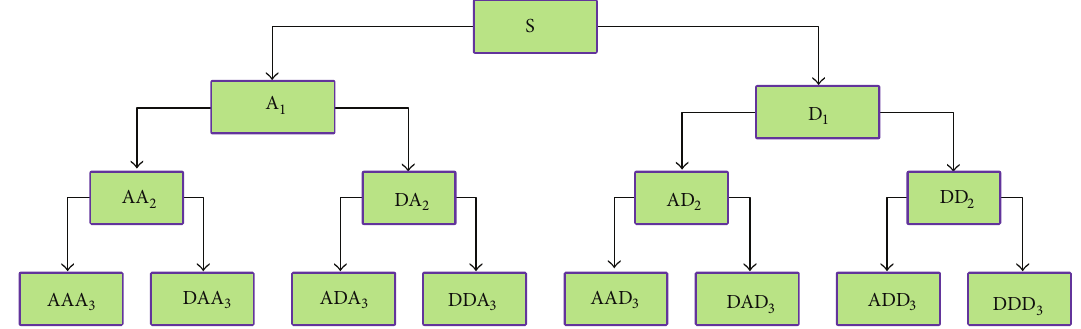
Figure 4: Wavelet packets decomposition tree at level 3.